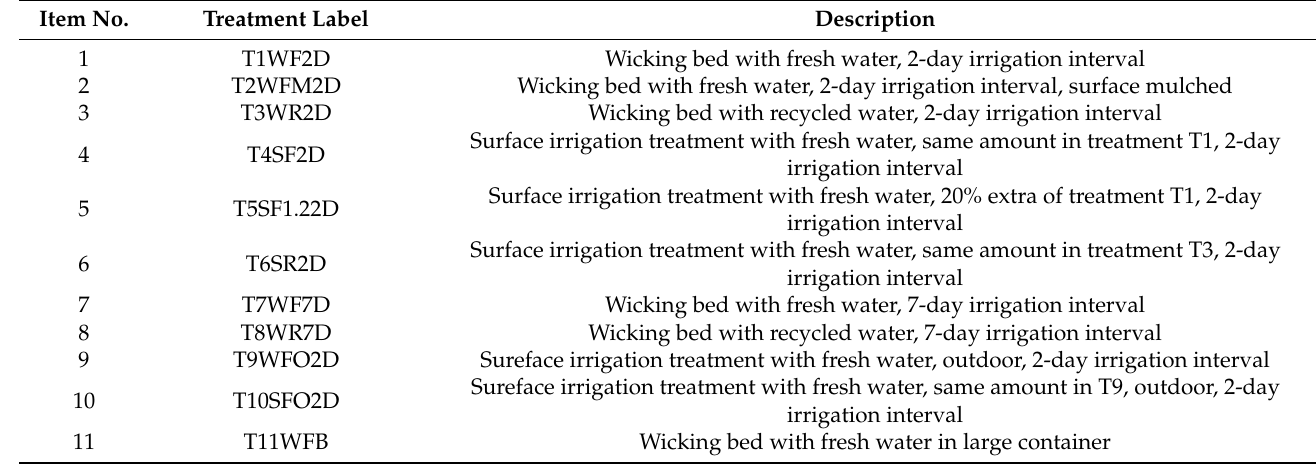
Table 2. Different irrigation treatments and irrigation